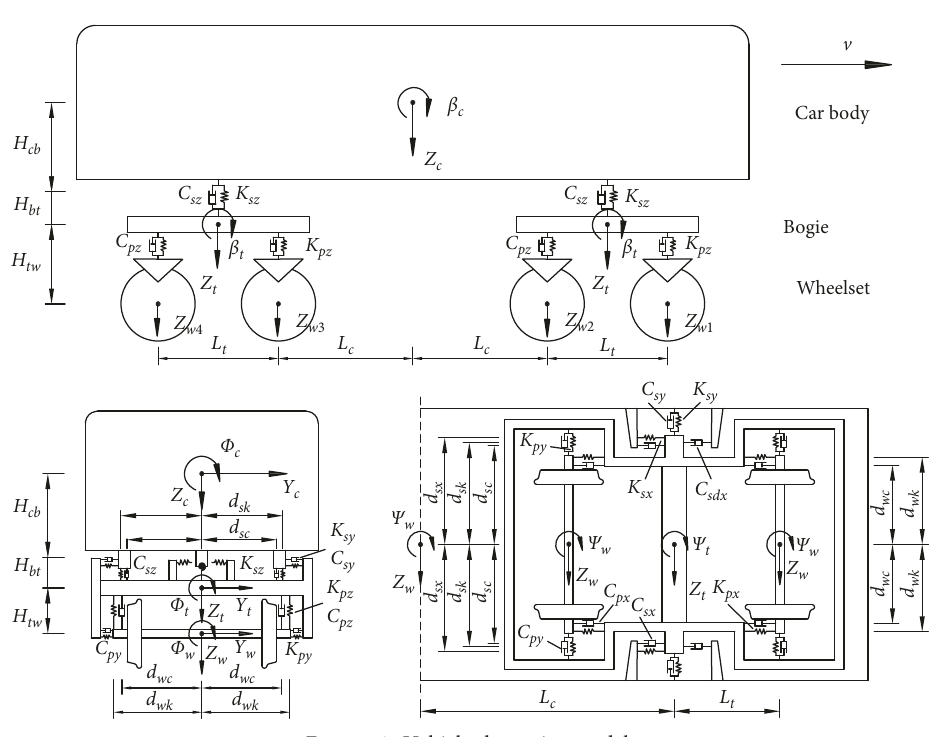
Figure 3: Vehicle dynamics model.